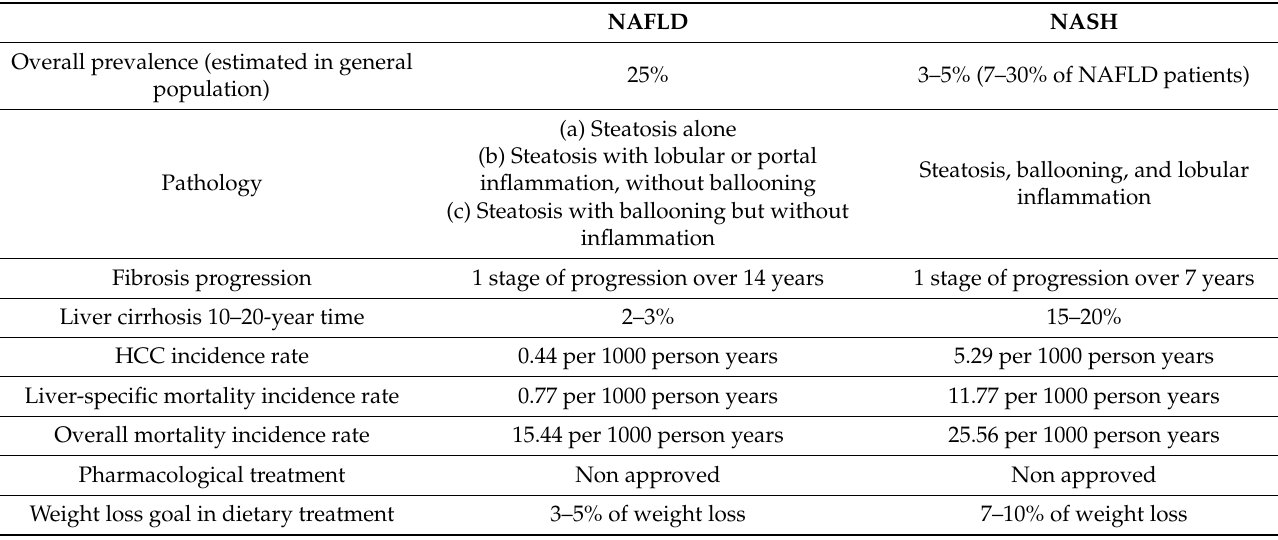
Table 1. Epidemiological and pathological differences between NAFLD and NASH, and their respective minimum weight loss goals in dietary treatment [13,14].